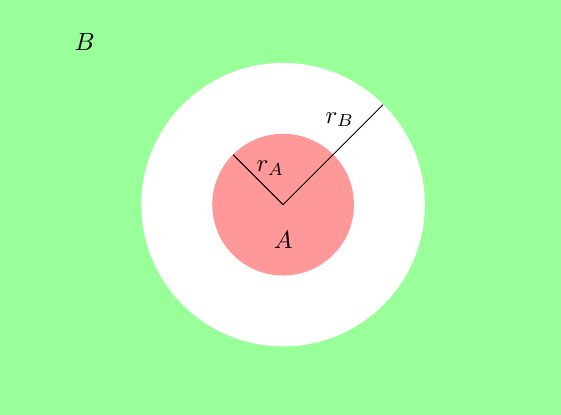
Figure 12 . The polar caps A and B on the t = 0 slice of R (cid:2) S 2 are mapped to balls centered at r = 0 and r = 1 on the (cid:28) = 0 slice of R 1 ; 2